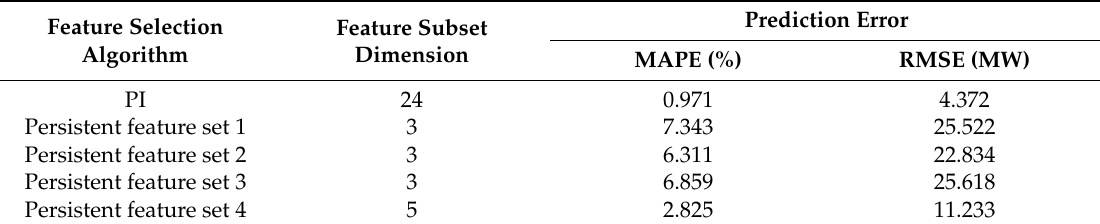
Table 8. Comparison of permutation importance (PI) and three empirical feature selection algorithms when 1-h-ahead prediction is conducted.